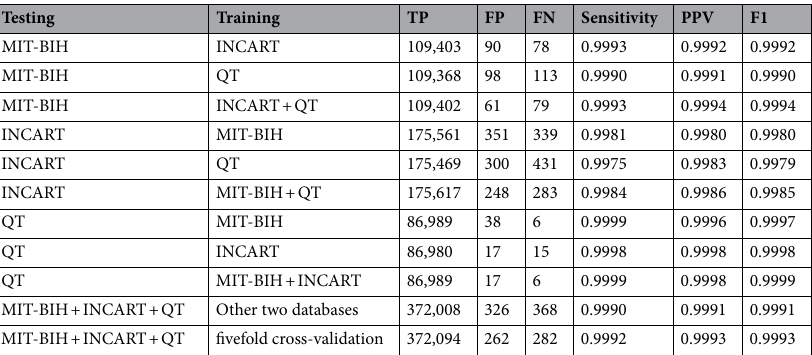
Table 1. Model performance according to the training and testing